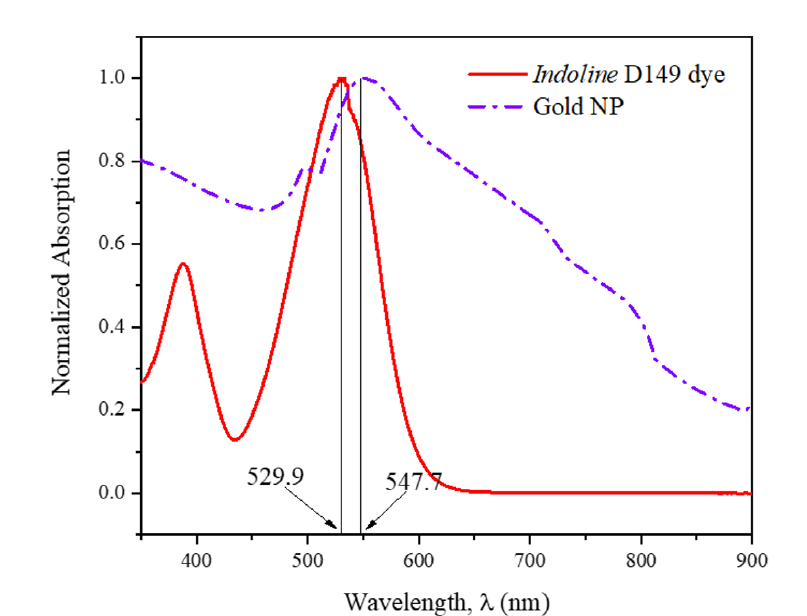
Figure 2 : Optical absorption spectra of the sensitizing dye, Indoline D149, (Red colour, solid line) and colloidal Au NPs (Purple colour, dash–dotted